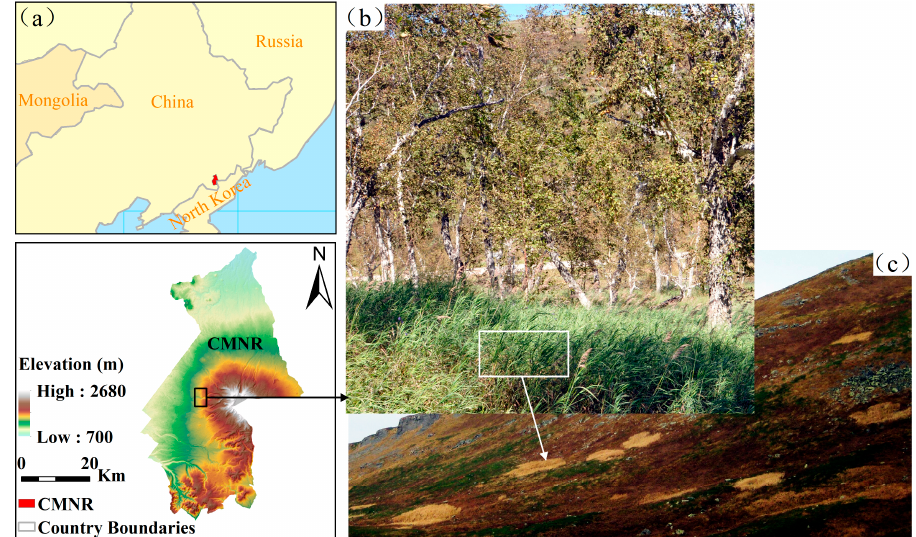
Figure 1. Location of the Changbai Mountain Nature Reserve (CMNR) in Northeastern China ( a ), mountain birch and Deyeuxia angustifolia (inset) communities in mountain birch forests located between 1700 and 2000 m ( b ), and alpine tundra (above 2000 m) with patches of encroaching D. angustifolia located on the western aspect of the Changbai Mountains ( c ).